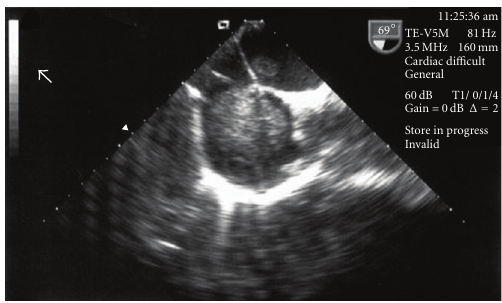
Figure 1: TEE image showing a very large echogenic mass in the right atrium.